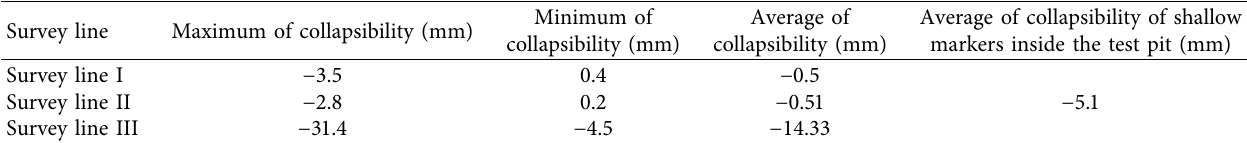
Table 5: Self-weight collapsibility of shallow markers inside the test pit.